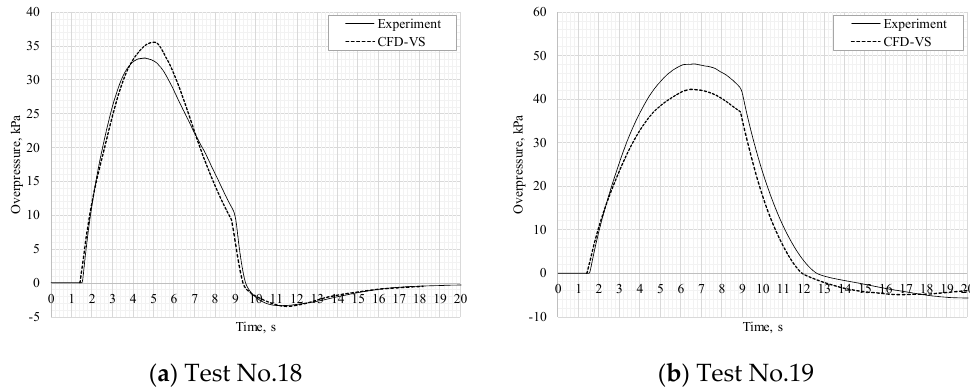
Figure 6. Pressure dynamics in the enclosure: CFD simulations with CFL = 0.75 versus experiments: ( a ) Test No.18 ( 𝑃 (cid:3020) = 12.46 MPa, 𝑚 (cid:4662) = 11.47 g/s, Number of experimental vents = 2); ( b ) Test No.19 ( 𝑃 (cid:3020) = 8.93 MPa, 𝑚(cid:4662) = 8.62 g/s, Number of experimental vents = 1).